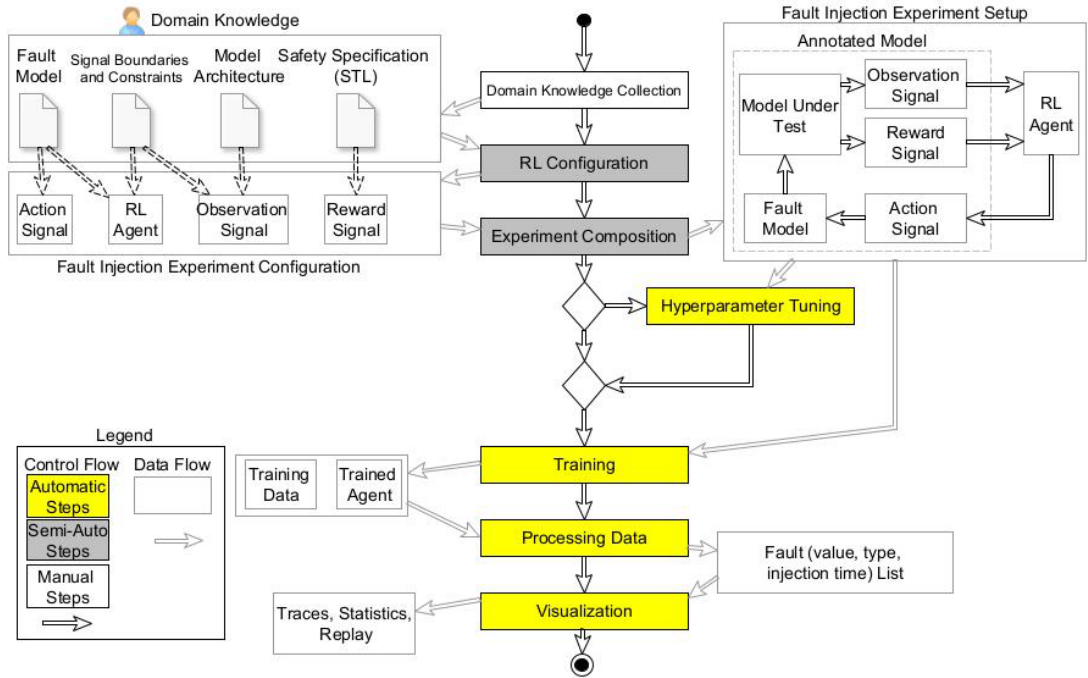
Figure 2. Overview of the proposed